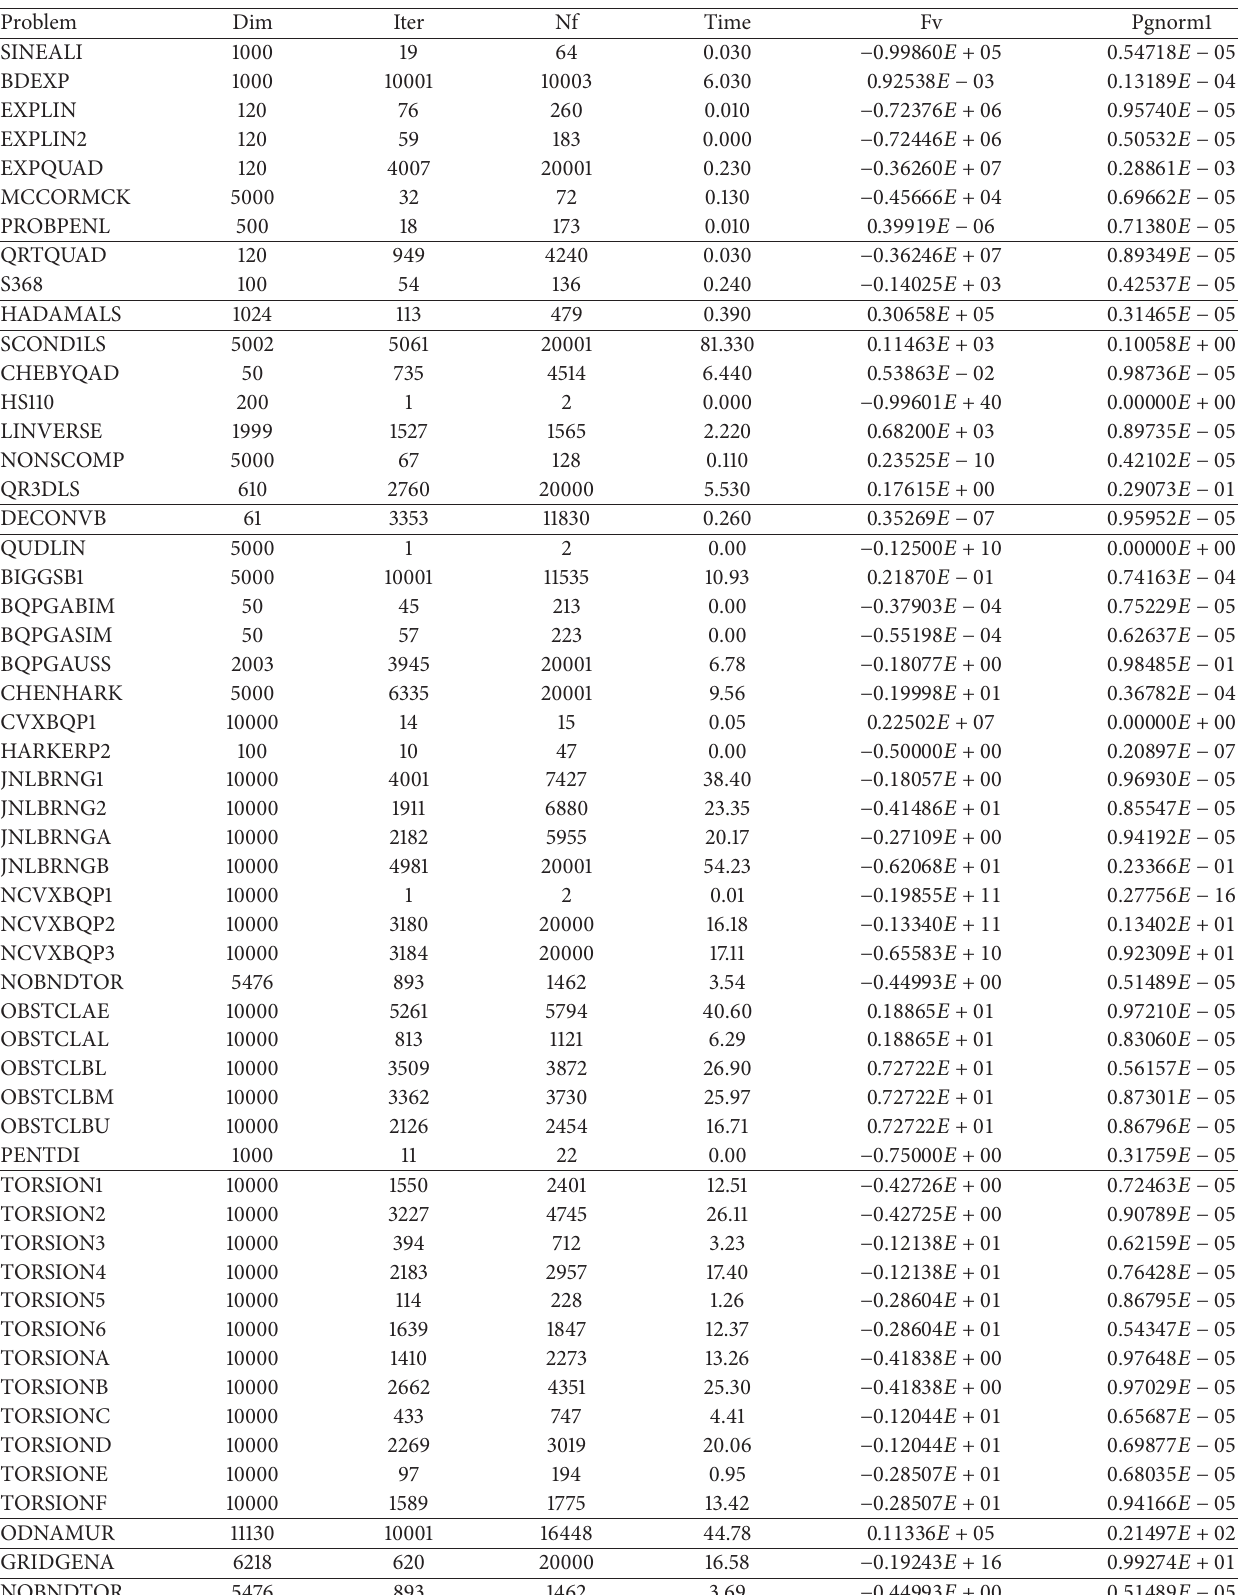
Table 2: Performance of